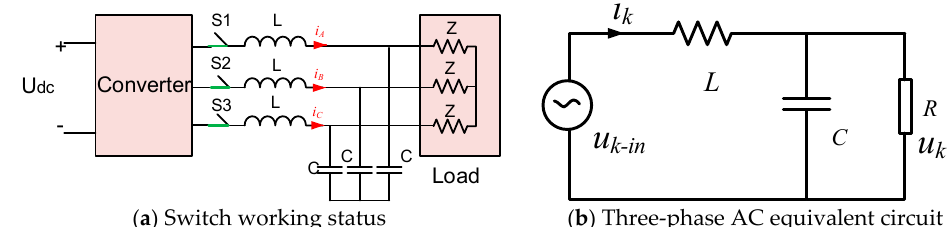
Figure 3. Structure of three-phase AC charging mode.